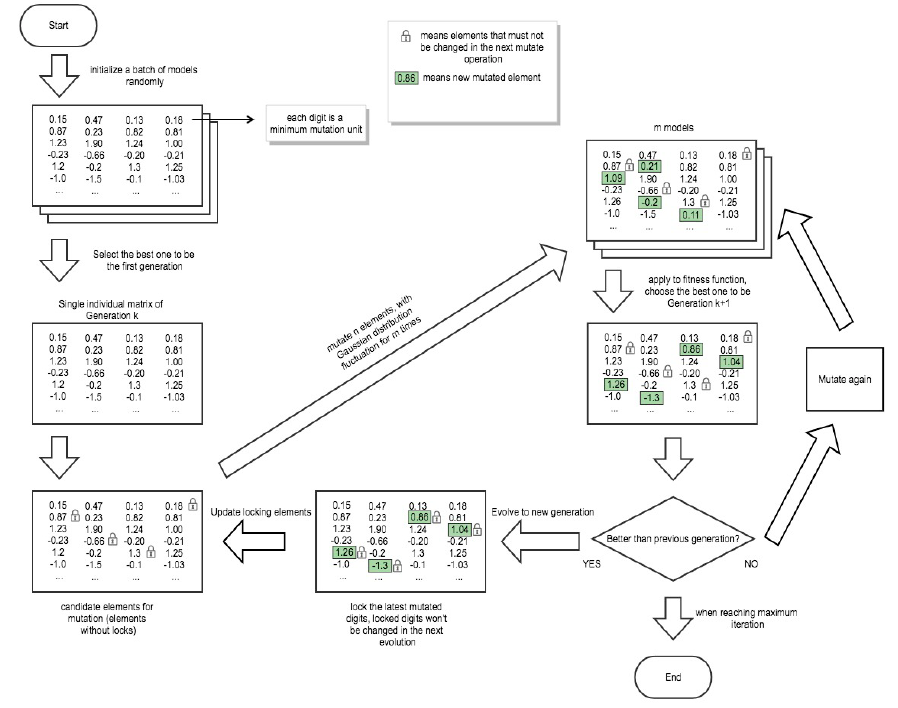
Figure 1. Flow chart of the G-ELM (Genetic Extreme Learning Machine) procedure.